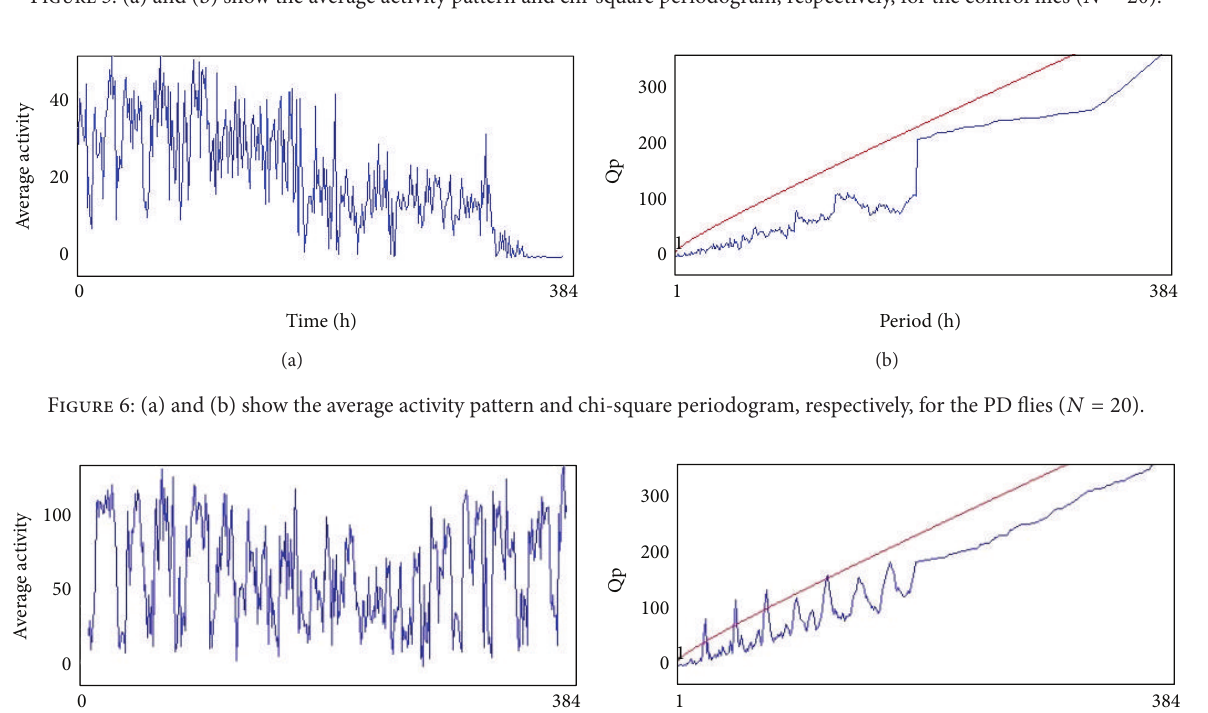
Figure 5: (a) and (b) show the average activity pattern and chi-square periodogram, respectively, for the control flies ( 𝑁 = 20 ).